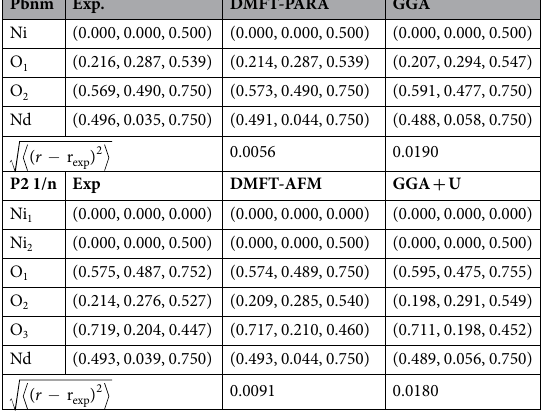
Table 1. Optimized atomic positions in the metallic and insulating state of NdNiO 3 . Experimental structure is from ref. 2. The GGA and GGA + U structure is from ref.